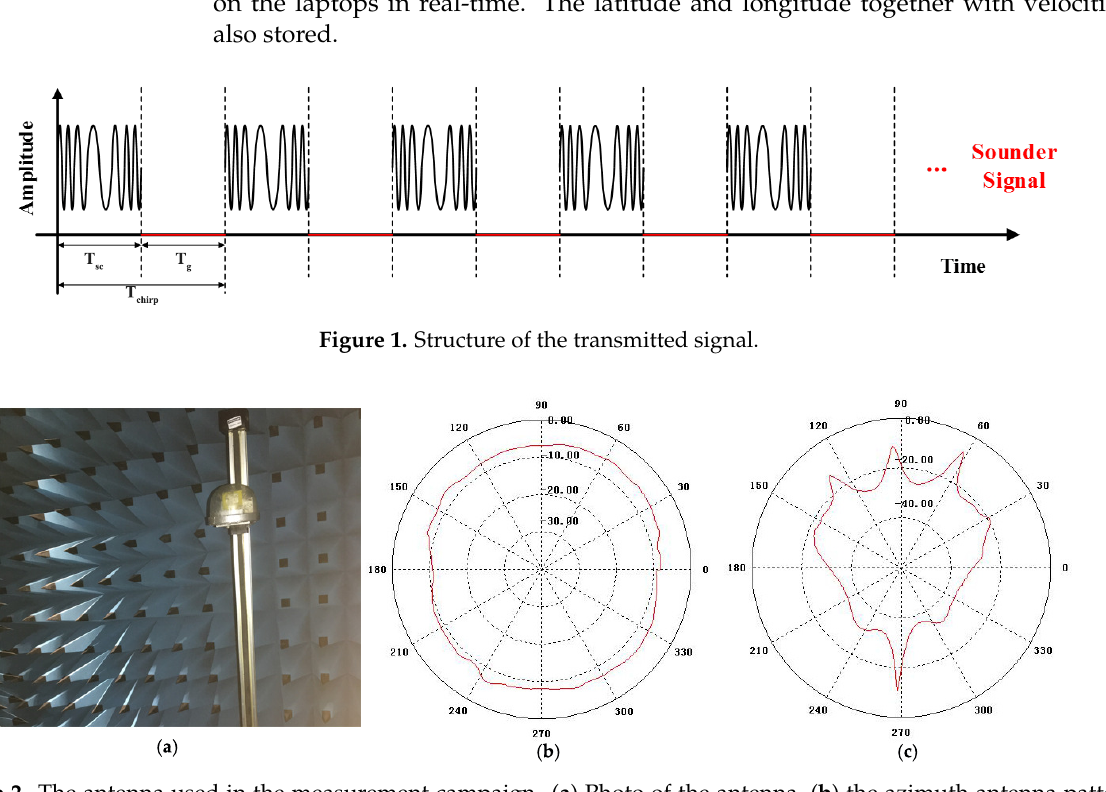
Figure 2. The antenna used in the measurement campaign. ( a ) Photo of the antenna, ( b ) the azimuth antenna pattern, and ( c ) the elevation antenna